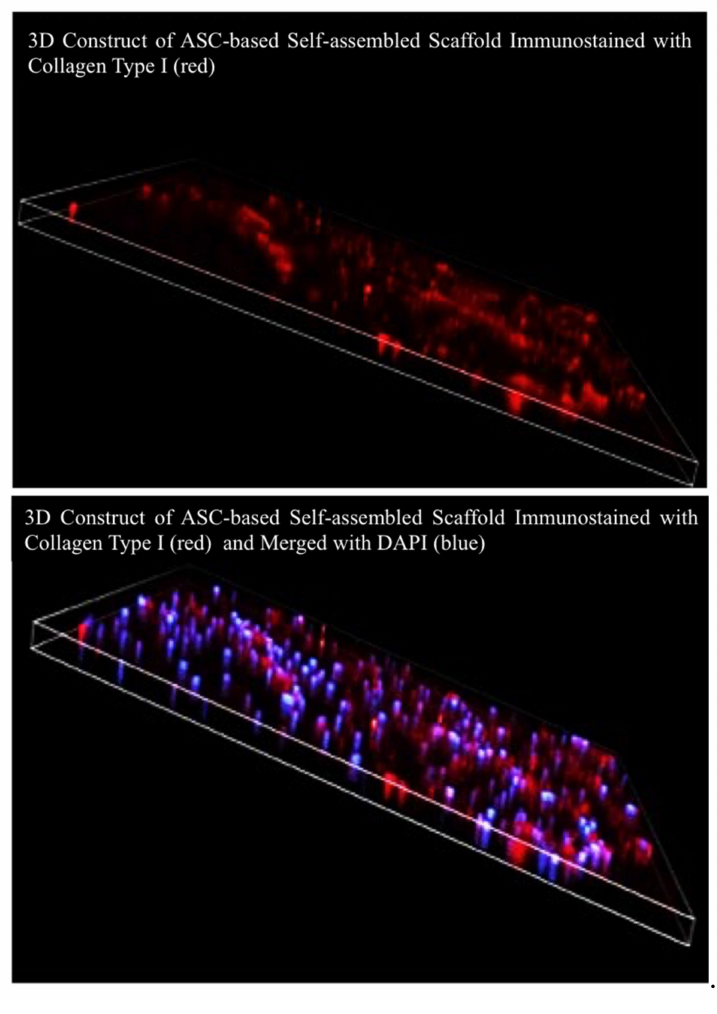
Figure 12. Graphical illustration of method used in measuring the thickness of self-assembled scaffold. The graph shows the 3D construct of ASC-based self-assembled scaffold, stained with collagen type I in red and merged with DAPI in blue (nucleus